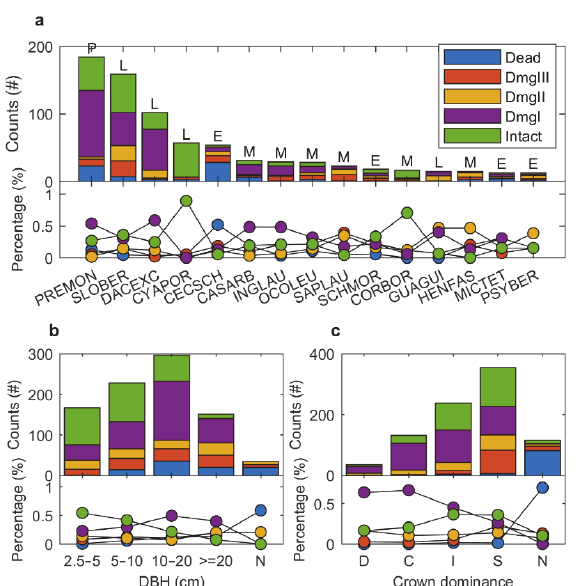
Figure 1. Forest damage three months after hurricane Mar í a at Bisley Experimental Watersheds (BEW). Stem counts (#) and percentage (%) of different levels of damage for ( a ) each species, ( b ) each diameter (DBH) class, and ( c ) each crown-dominance class. Damage categories I, II, and III are light damage (<50% of defoliation), intermediate damage (>50% of defoliation or branches broken), and heavy damage (stem or root broken), respectively. Letters above the bar of the species indicate the successional type of the species: palm (P), early (E), mid (M), and late (L) successional trees. Letter N in panel ( b ) represents not measured. Letters D, C, I, and N in panel ( c ) represent crown-dominance classes: dominant (D), co-dominant (C), intermediate (I), suppressed (S), and not-measured (N). The data used to produce ( a – c ) are also listed in Tables S3–S5, respectively.